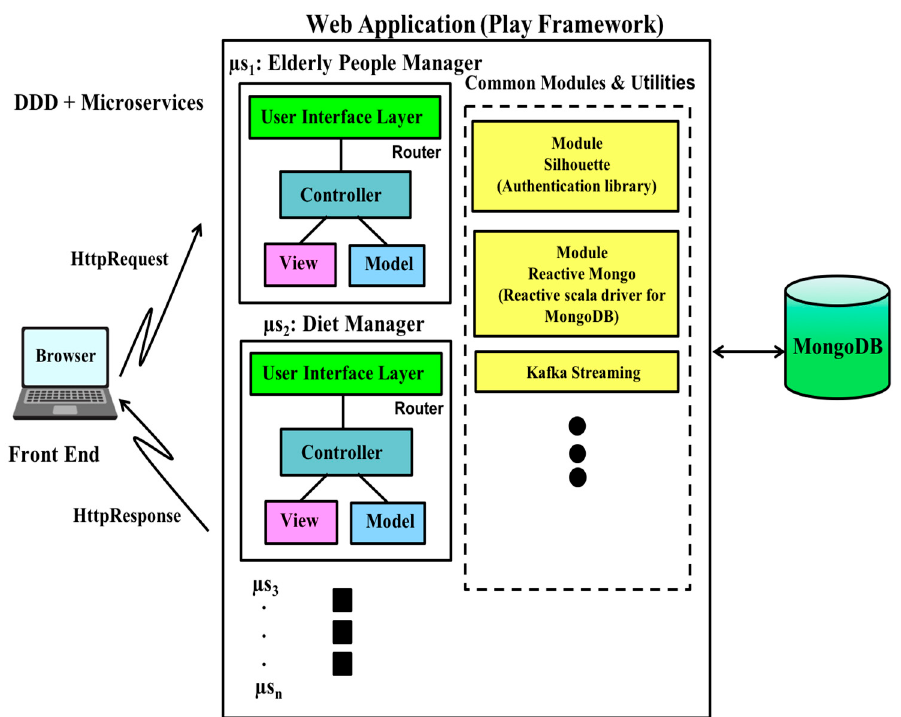
Figure 10. The microservices of the e-health system are designed with an MVC design pattern. The graphical user interfaces provide access to core services and diet management services.